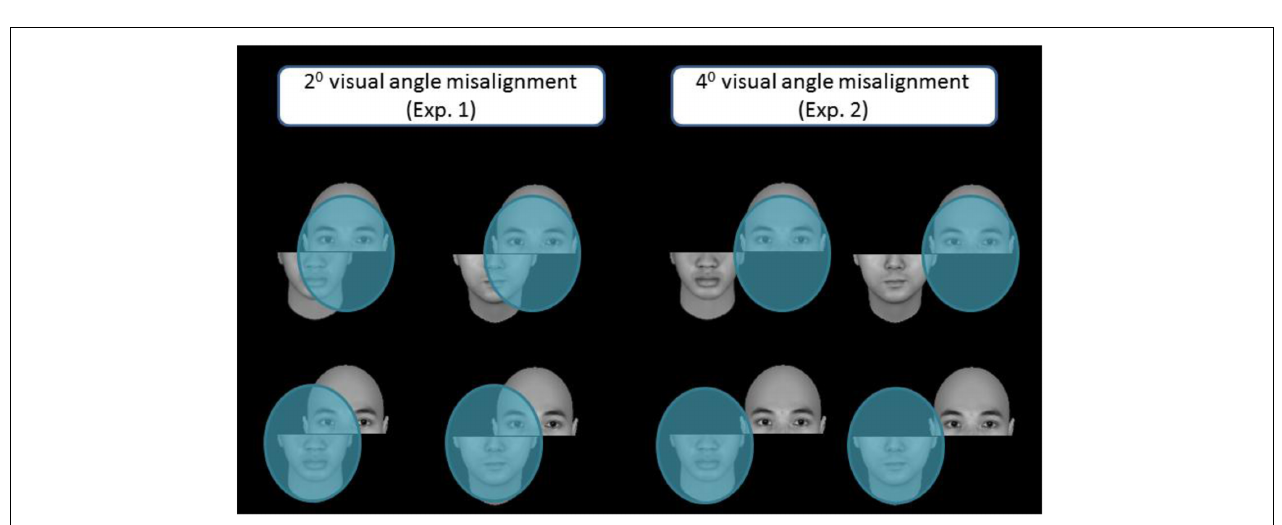
FIGURE 5 | Congruency effects, defined as differences in d ’ between congruent and incongruent trials, as a function of face part (top vs. bottom) and alignment (aligned vs. misaligned) in Experiment 1. Error bar indicated ± 1 standard error of mean.